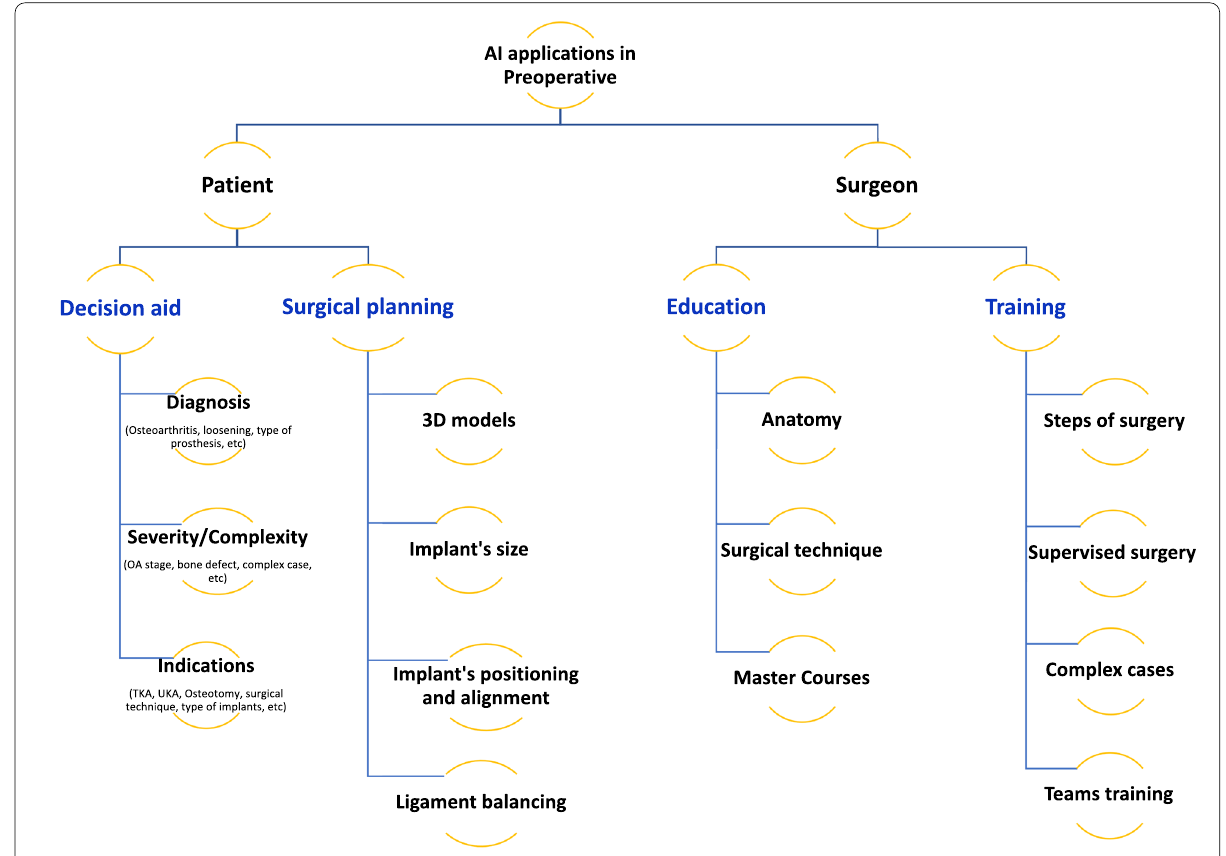
Fig. 2 Structure chart resuming the preoperative major AI